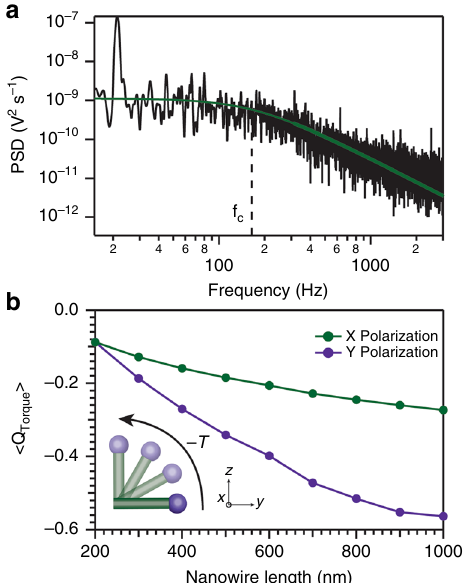
Fig. 2 Optical trapping and orientation of metal-seeded nanowires. The power spectrum ( a ) of an optically trapped germanium nanowire was collected via back-focal-plane interferometry and shows radial con fi nement of the nanowire. The green line shows a fi t of the power spectrum to a Lorentzian with a corner frequency of 164 Hz, highlighted by the dashed line. The spike at low frequency is used to calibrate the nanowire position. Prior to optical trapping, far from the focal plane, the nanowire experiences a scattering-induced alignment torque due to the axial anisotropy of the bismuth-tipped nanostructure. Panel b illustrates the torque for a y - polarized plane wave averaged over all theta angles of the